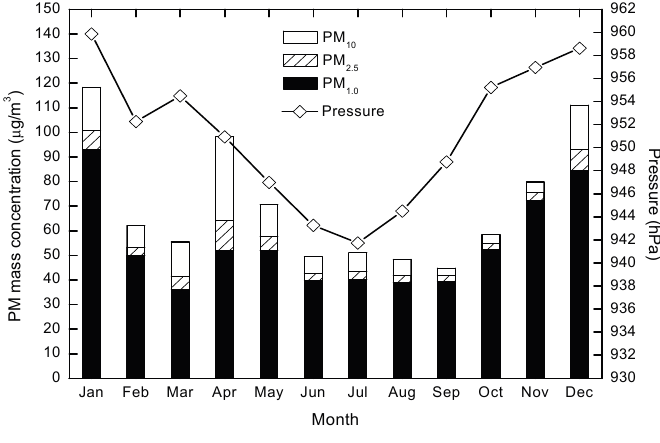
Figure 5. Variations in monthly mass concentrations of PM 10 , PM 2.5 and PM 1.0 related to air